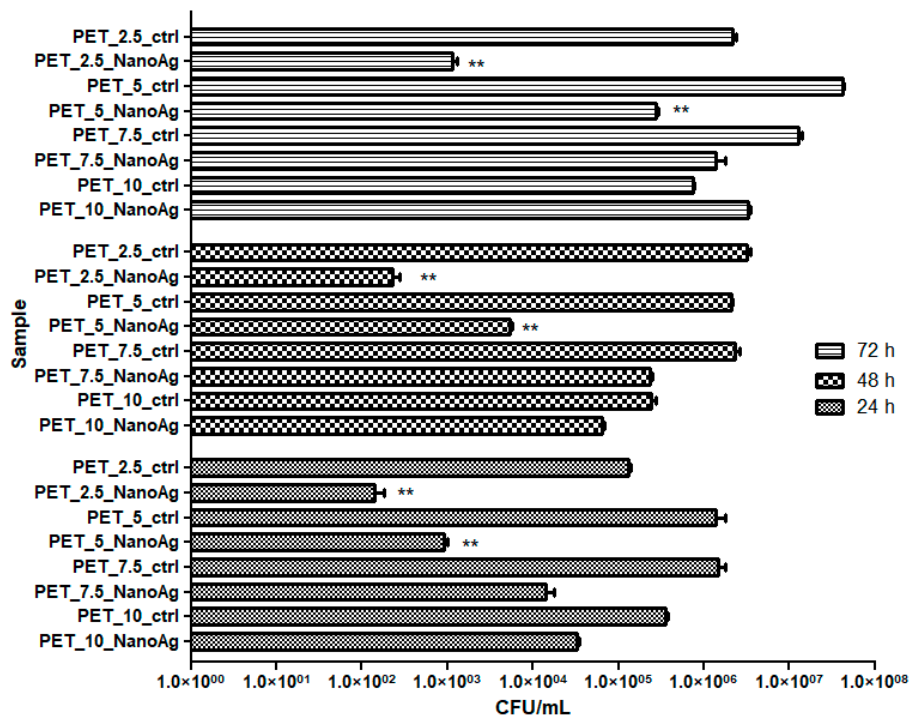
Figure 10. Graphic representation of CFU/mL representing the number of C. albicans cells viable cells included in the monospecific biofilms developed on the surface of the materials, quantified after 24 h, 48 h, and 72 h at 37 °C. * p ≤ 0.001, ** p ≤ 0.05 comparing control PET and NanoAg PET obtained at the same flow rate.